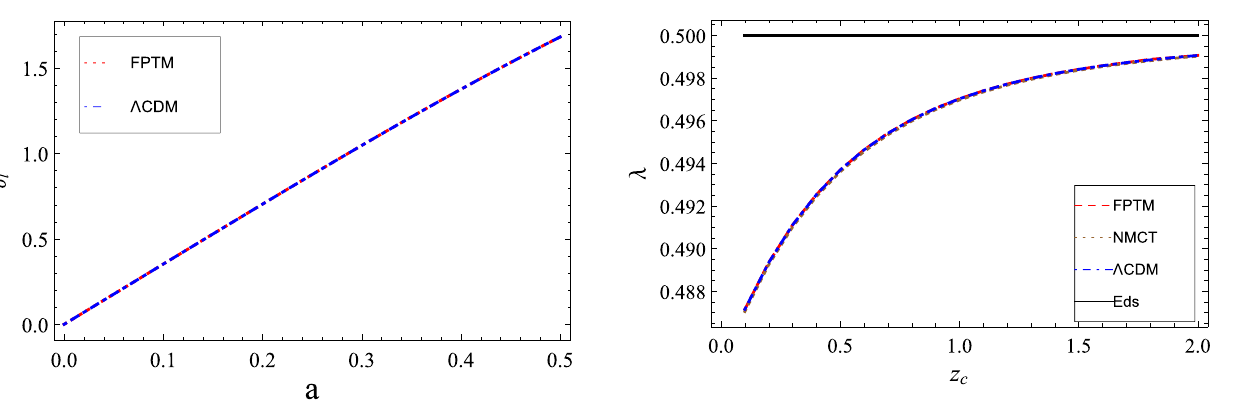
Fig. 16 The evolution of the radius of structure λ versus z c for the Λ CDM , FPTM, NMCT and Eds models